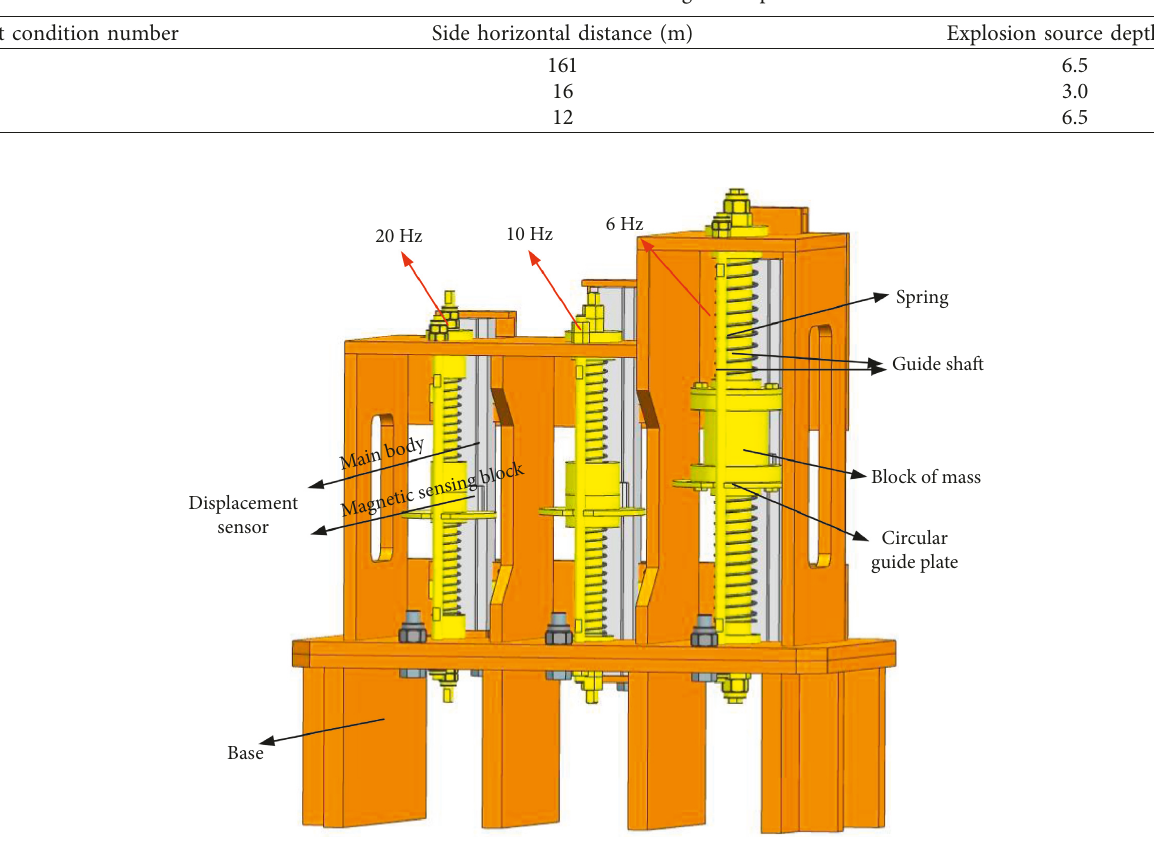
Figure 2: Schematic diagram of the vertical oscillator